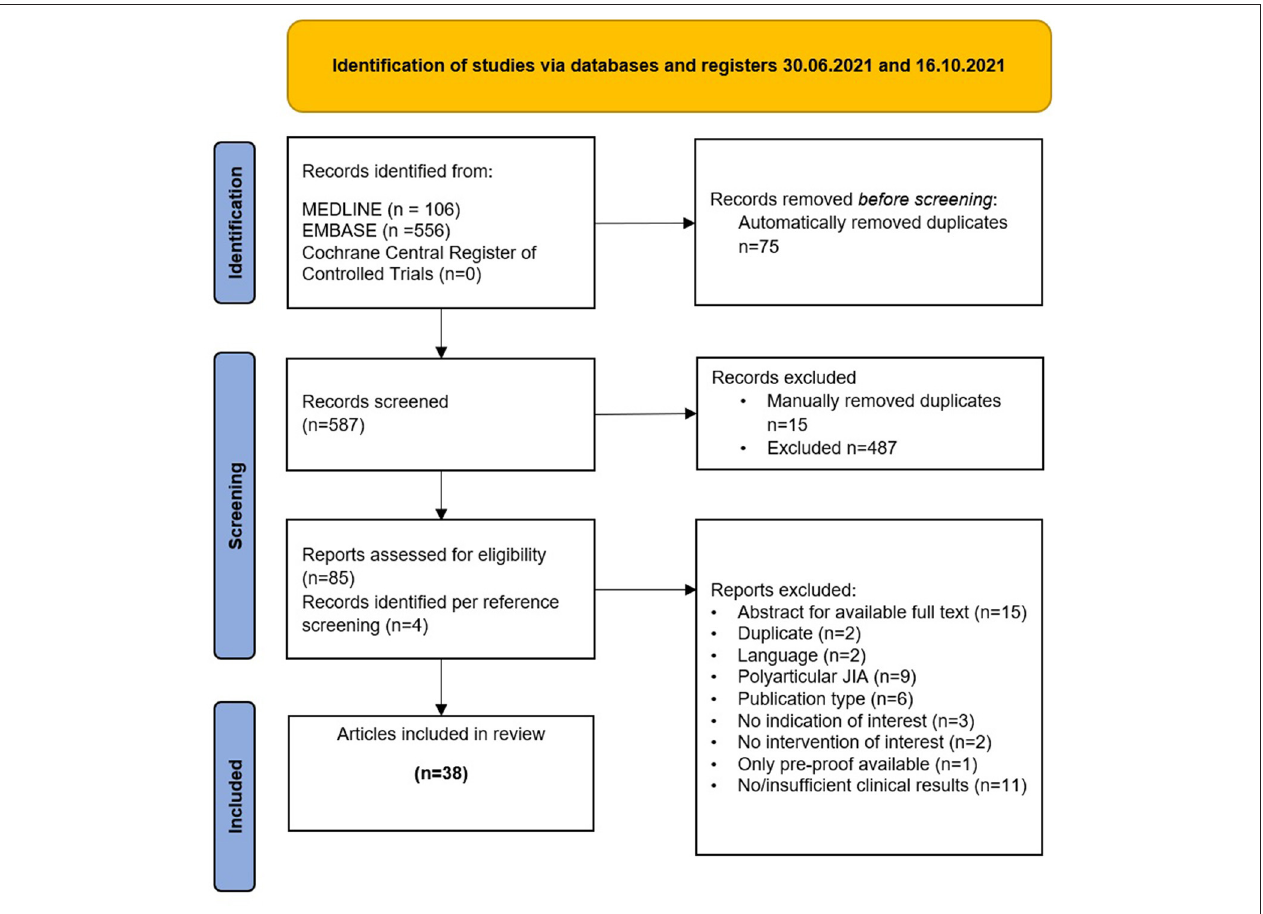
FIGURE 1 | Identification of studies via databases and registers 30.06.2021 and